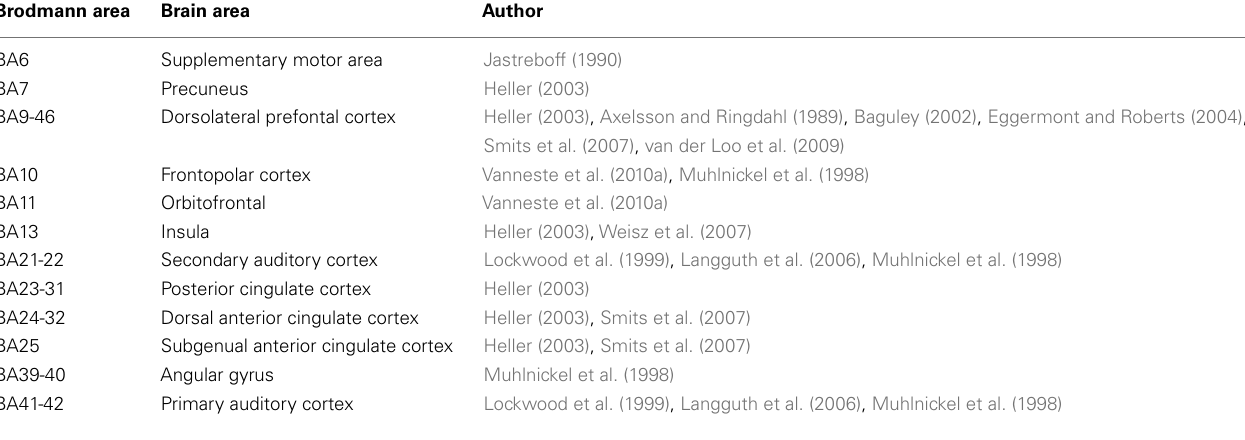
Table 2 | Regions of